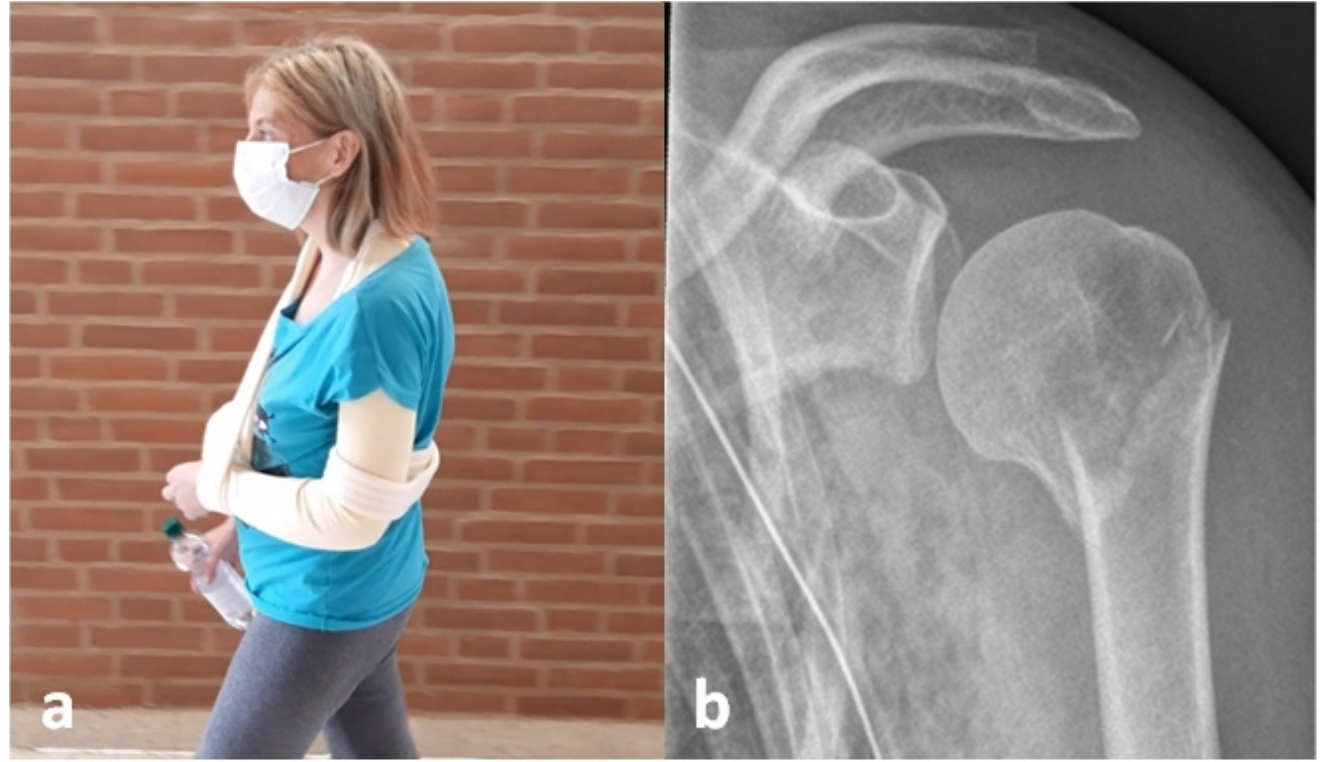
Figure 4. The patient was, several days later, able to walk independently ( a ). An anteroposterior X-ray control before chest tube removal in an upright standing position indicates a nearly anatomic HSA ( b ).